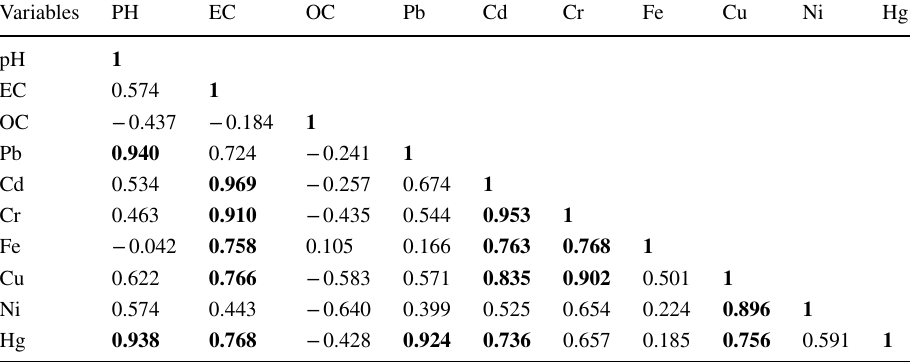
Values in bold correspond to each variable to the factor for which the squared cosine is the Table 11 Pearson’s correlation matrix for analyzed variables in sediment samples